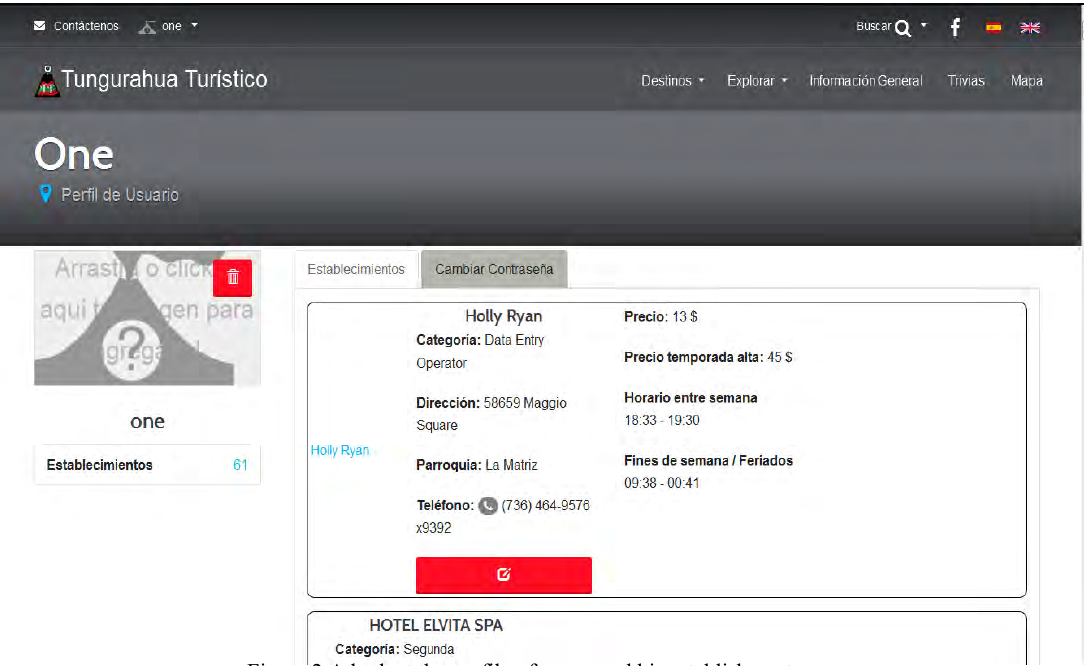
Figure 2 A look at the profile of a user and his